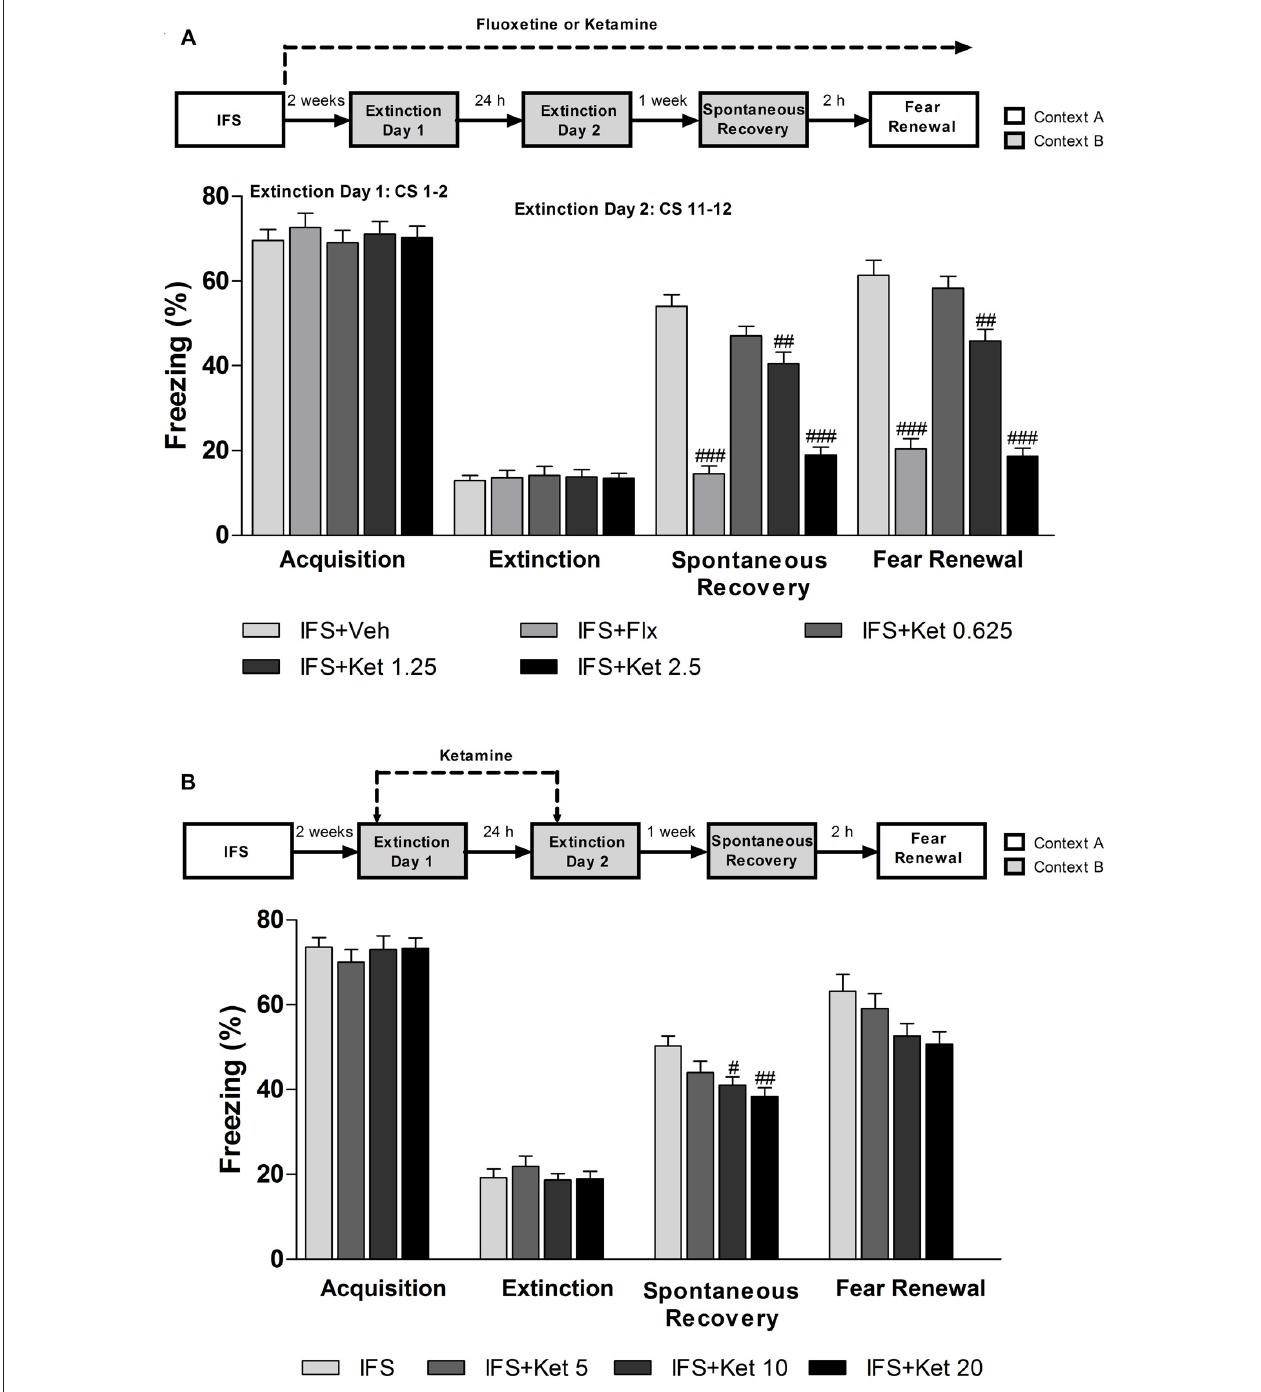
FIGURE 5 | The effect of ketamine treatment on the fear erasure when combined with extinction training. (A) After IFS, the mice were treated with Flx or ketamine, and continued throughout the experiment. After 2 weeks of Flx or ketamine treatment, mice were subjected extinction training. A week later, spontaneous recovery of fear and renewal were performed to explore whether this fear reduction was permanent. All the groups exhibited similar levels of fear acquisition (extinction day 1, first 2 CS) and extinction (extinction day 2, last 2 CS). One week later, only IFS + Veh and IFS + 0.625 mg/kg ketamine groups showed elevated spontaneous recovery and significant fear renewal. The IFS + Flx and IFS + 1.25 and IFS + 2.5 mg/kg ketamine groups froze less than the IFS + Veh group. (B) Ketamine (5, 10, or 20 mg/kg) treatment started 2 h prior to the extinction training. The four groups exhibited similar levels of fear acquisition and extinction. One week later only IFS + 10 and IFS + 20 mg/kg ketamine groups froze less than the IFS + Veh group in the spontaneous recovery. All the groups showed the fear relapse. Data are presented as mean ± SEM ( n = 15 in per group). # P < 0.05, ## P < 0.01, ### P < 0.001 compared with the IFS + Veh group.